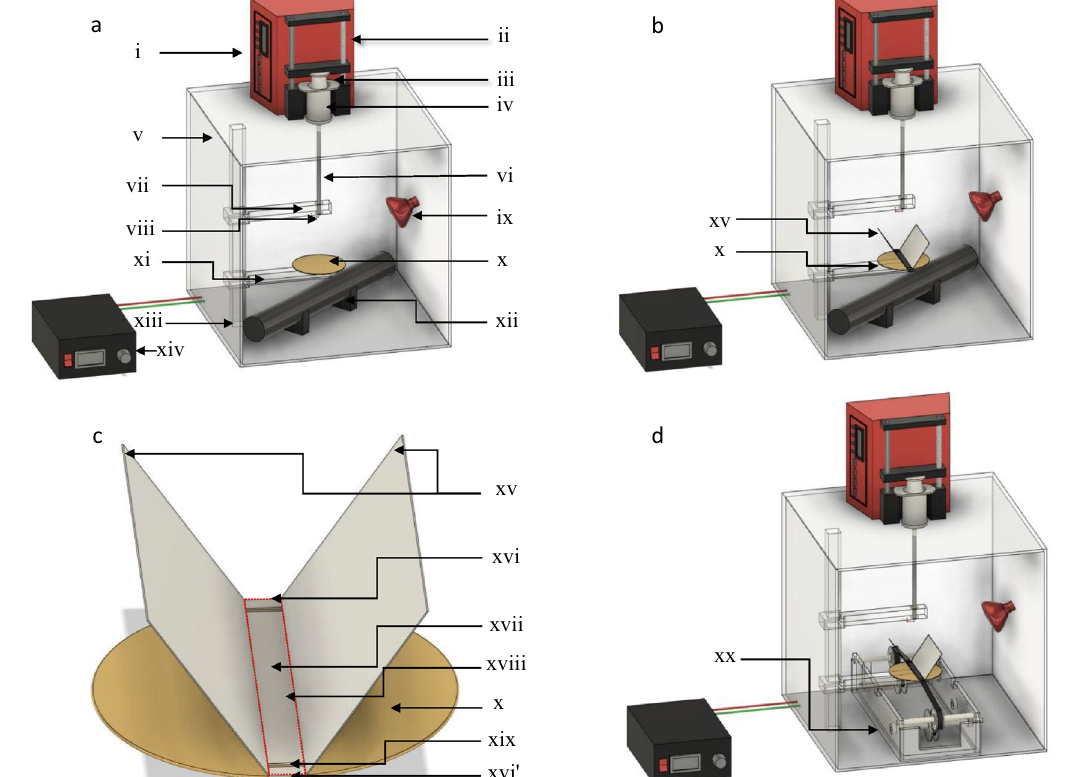
Figure 1. ( a ) Schematic illustration of a conventional electro-spinning setup; ( b ) the new Vee-shield experimental setup; ( c ) a magnified view of the Vee-shield; and ( d ) the motorised spooling rig for continuous production of aligned fibres. The coded items are as follows: (i) controller for the liquid dispensing system; (ii) screw-driven drive mechanism on the liquid dispenser; (iii) plunger of the syringe; (iv) barrel of the syringe; (v) Perspex chamber (with doors); (vi) PTFE tube that connects the tip of the syringe to the needle (via Luer Lock connectors); (vii) Perspex support arm for the needle; (viii) metal needle; (ix) infrared heat source; (x) circular grounded metal collector; (xi) Perspex support arm for the grounded collector; (xii) storage heater; (xiii) vertical Perspex support arm; (xiv) high-voltage DC power supply; (xv) PTFE Vee-shield; (xvi and xvi’) back and front edges of the ground electrode respectively; (xvii) strip of cellulose paper; (xviii) perimeter where the majority of the aligned fibres are deposited; and (xix) slot in the PTFE where the cellulose substrate is fed through when spooling (a similar slot is present on the opposite end); (xx) motorised spooling rig for the continuous production of aligned electro-spun